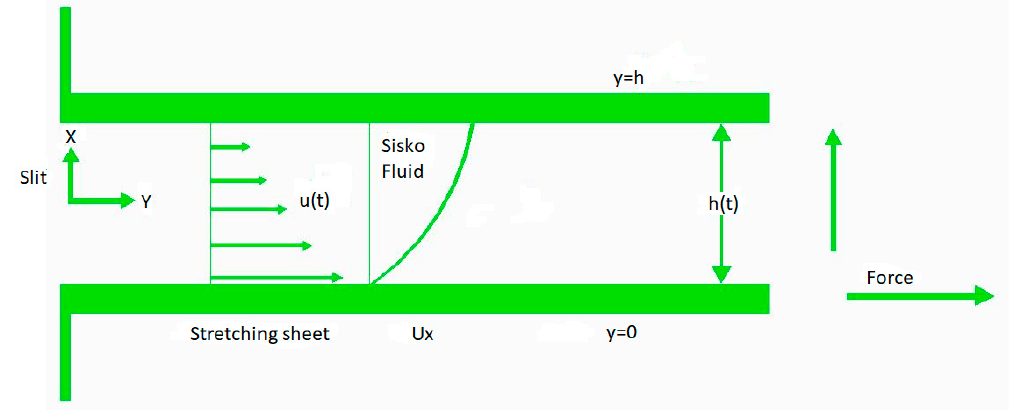
Figure 1. Physical Sketch of the model problem.